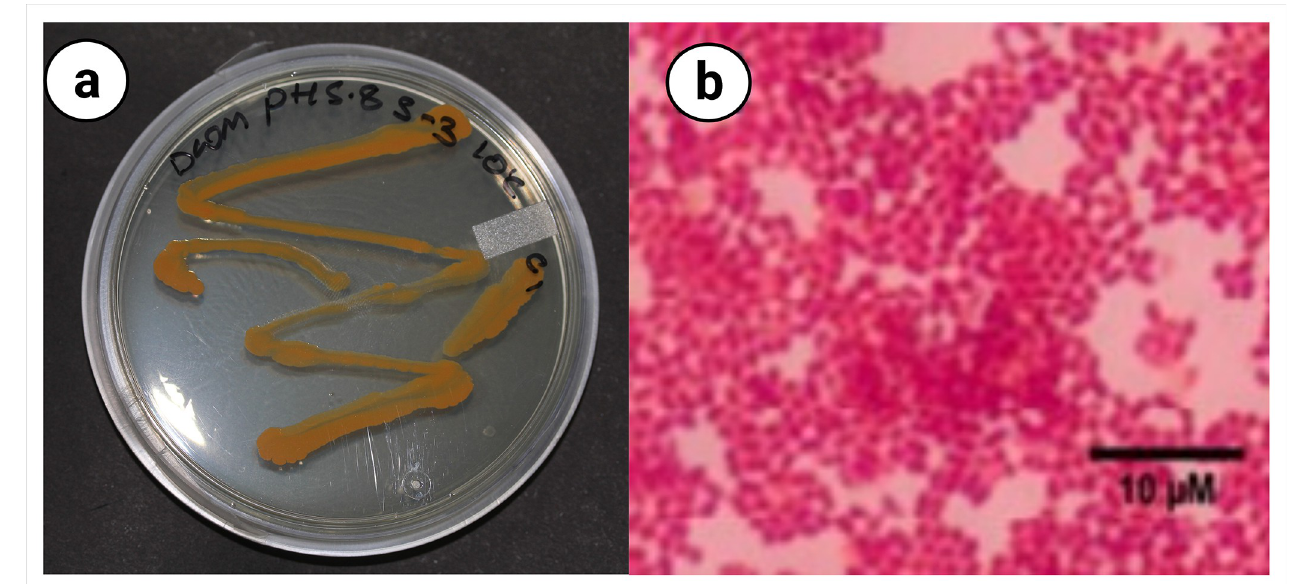
Fig 2. (a) The morphological features of strain analysed in this study (b) Stained bacterial cells of the isolates.